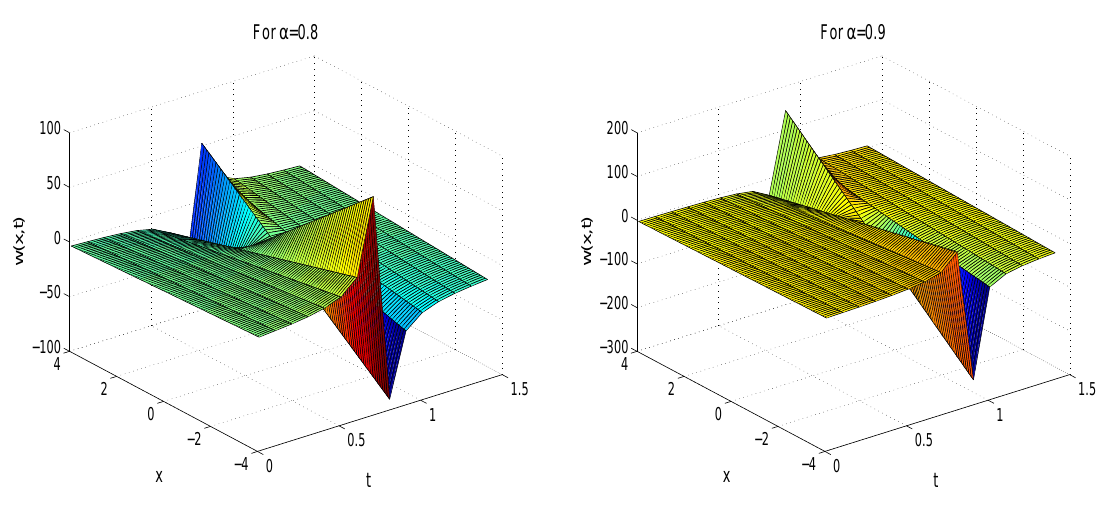
Figure 2. Effects on solution w ( x , t ) for α = 0.8 and α =